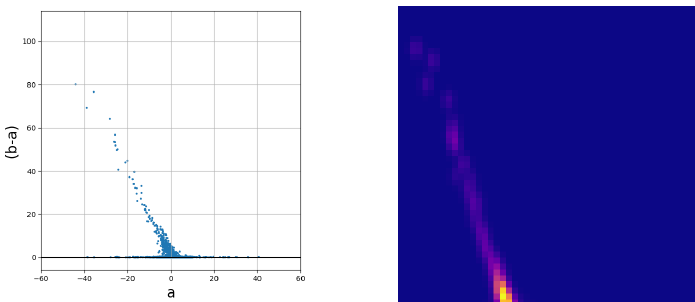
Figure A2. Relaxed driver with rigid seat.